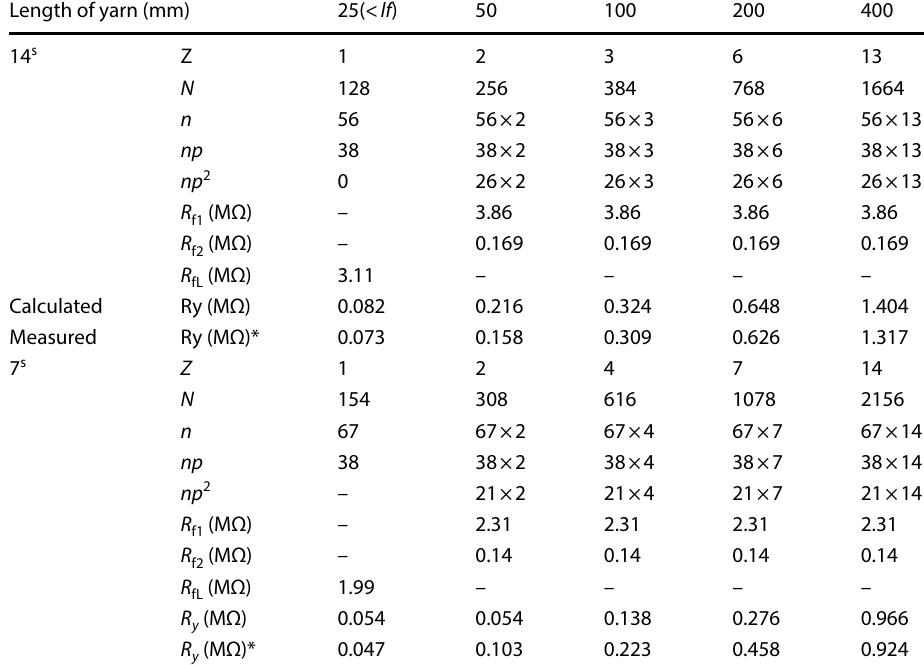
Table 3 Calculated and measured resistance of yarn with different